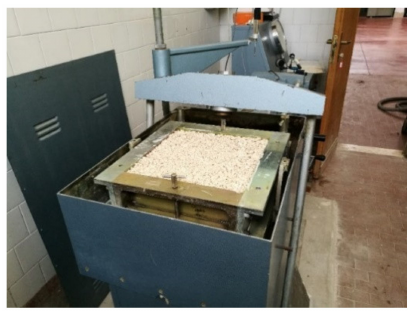
Figure 11. Box used for the cutting tests.